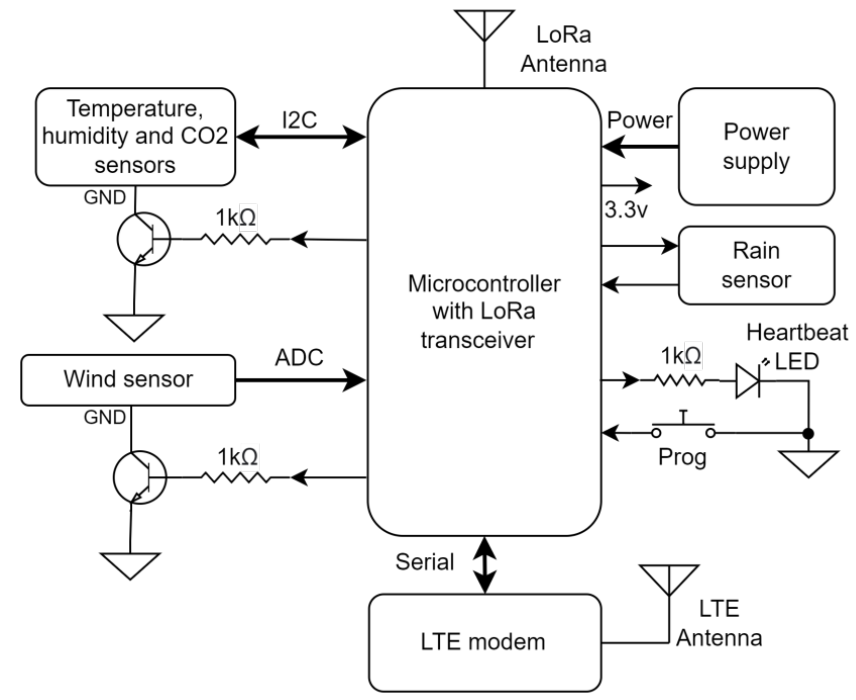
Figure 8. Block diagram of the hub node hardware.